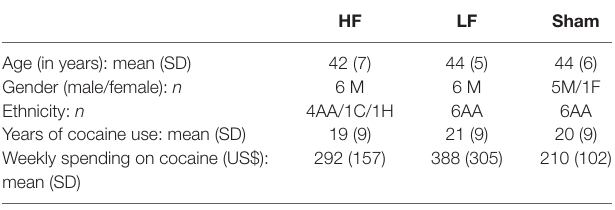
TaBle 1 | Demographic data of the three repetitive transcranial magnetic stimulation groups of subjects with cocaine use disorder ( N =